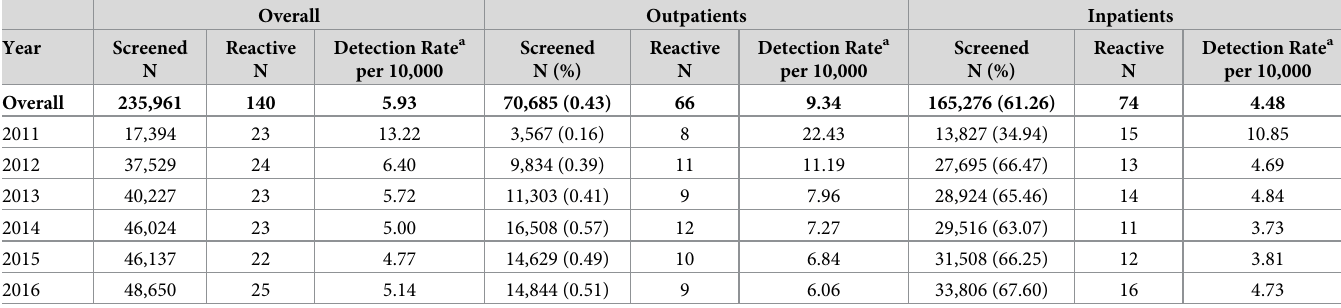
Table 2. HIV cases and detection rates, stratified by year and by patient status, at Xuanwu Hospital, Beijing, China, 2011–2016.